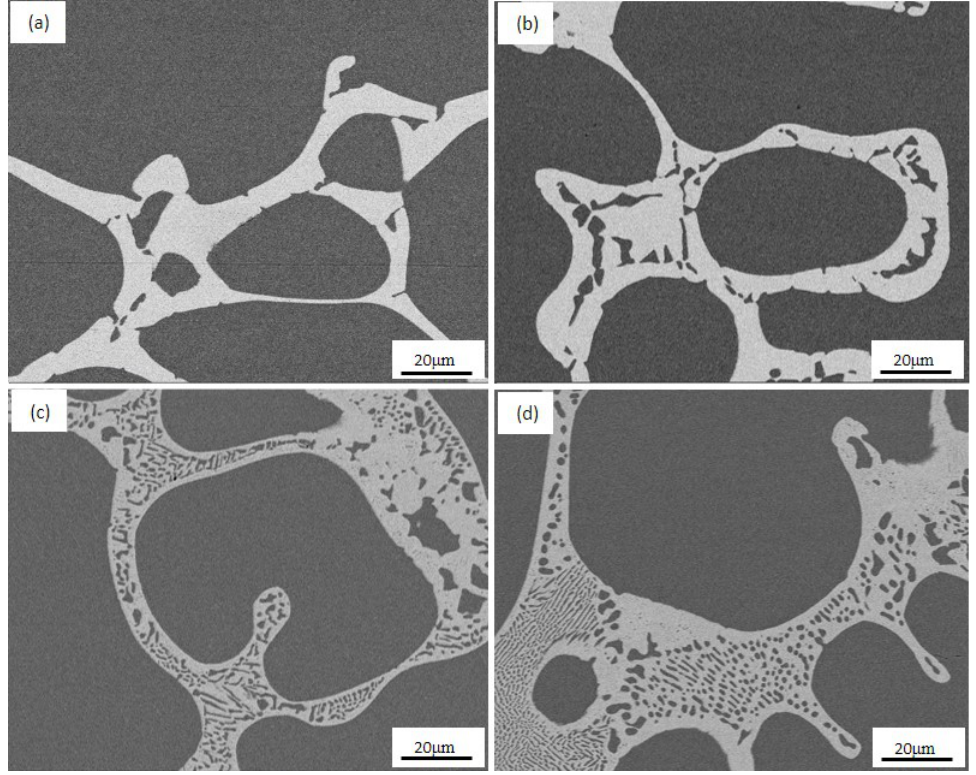
Figure 2. Microstructure of eutectics in the Fe-free alloy: ( a ) as-solid-solution, ( c ) 550 °C-4 h, and in the Fe-doping alloy: ( b ) as-solid-solution, ( d ) 550 °C-4 h.